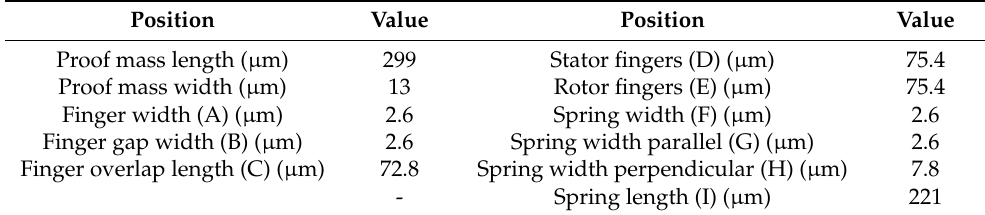
Figure 1. ( a ) The layout of the microelectromechanical system (MEMS) magnetometer; ( b ) marks on the combs and springs of the structure. Table 1. Dimensions of the MEMS magnetometer.